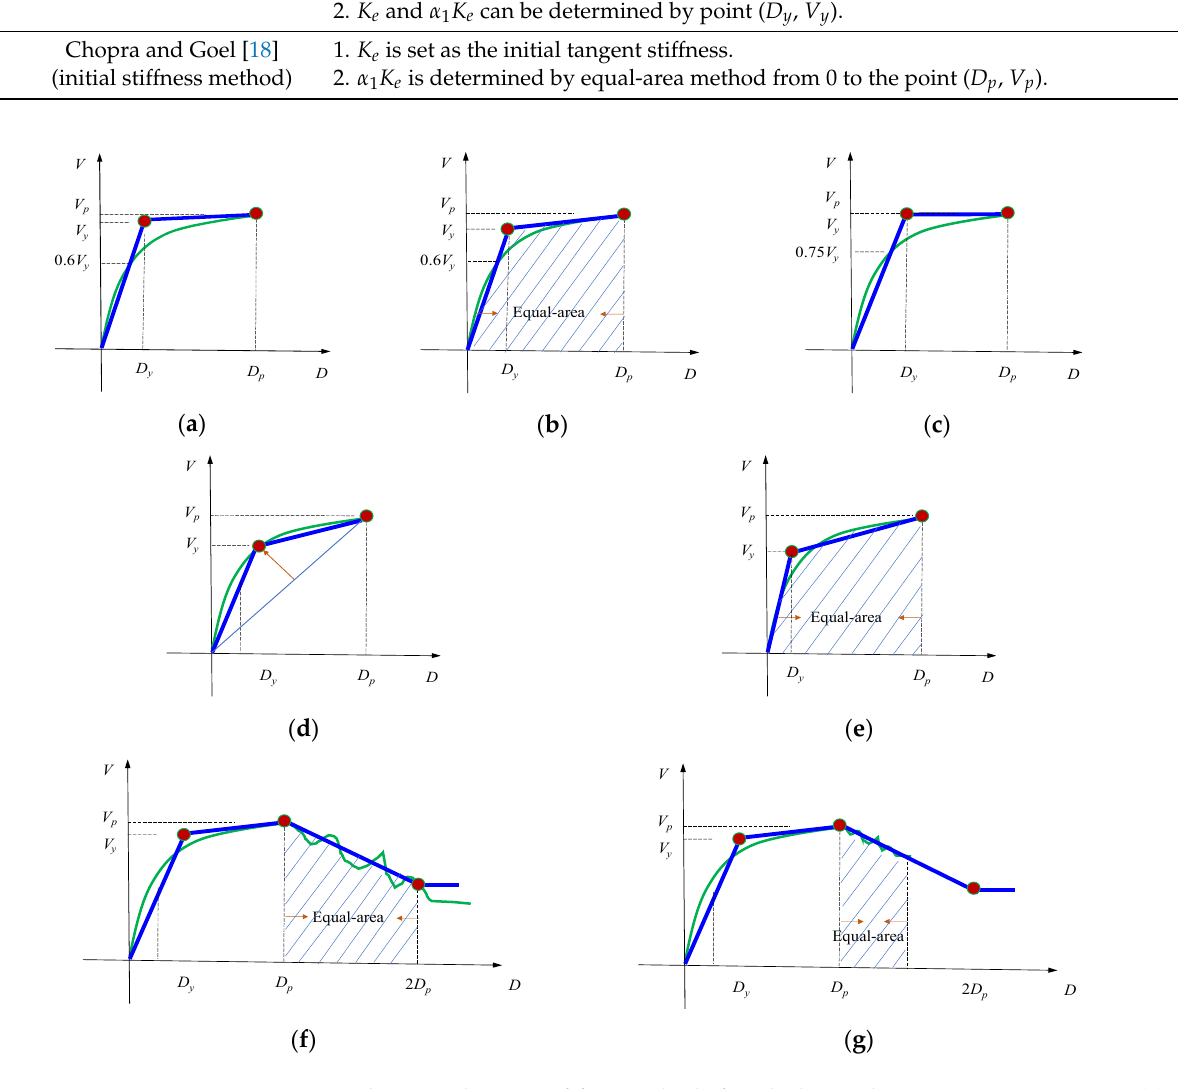
Figure 2. Schematic diagram of five methods for idealizing the story capacity curves. ( a ) ATC-40; ( b ) FEMA 356 (also FEMA 440, ASCE 41-13); ( c ) 0.75 V y ; ( d ) farthest point; ( e ) initial stiffness; ( f ) negative-stiffness region–Case 1; ( g ) negative-stiffness region–Case 2.